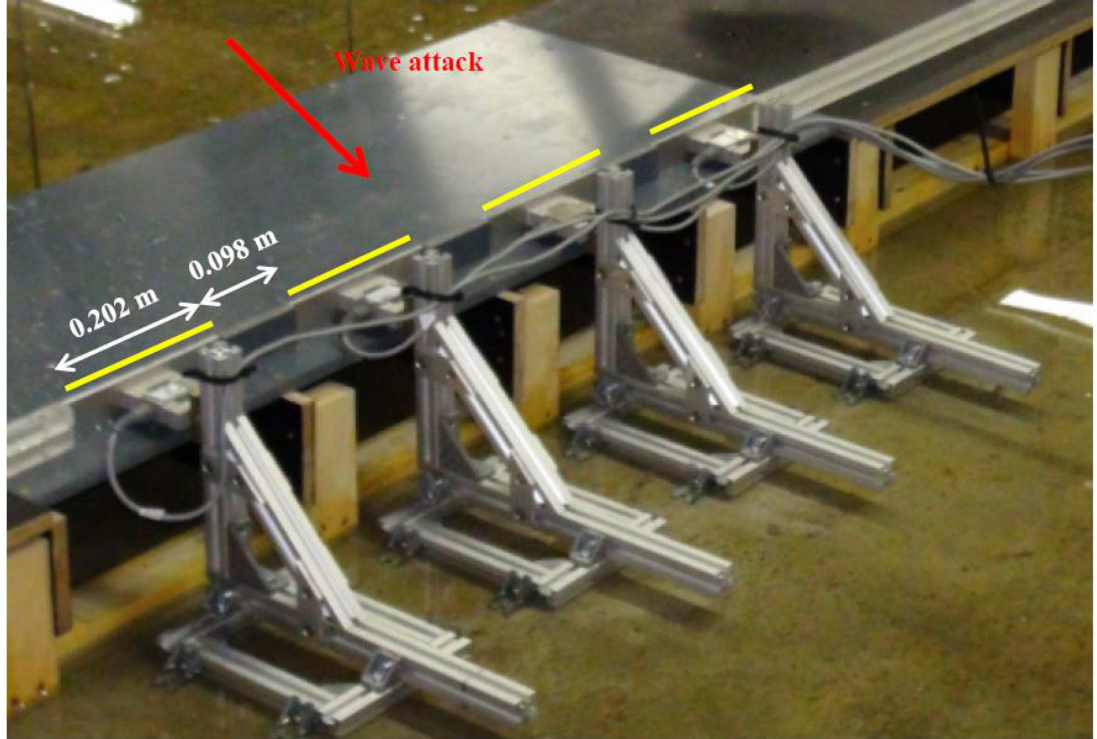
Figure 7. The part of the structure where the force sensors were installed (detailed picture).